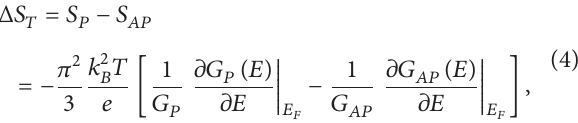
Figure 3: (a) Plot of the thermopower from Ba 2 FeMoO 6 at 8 T (filled up triangles) and 0 T (filled circles). (b) The resultant thermopower difference 𝑆(8 𝑇) − 𝑆(0 𝑇) . Also shown is the best fit line with a zero